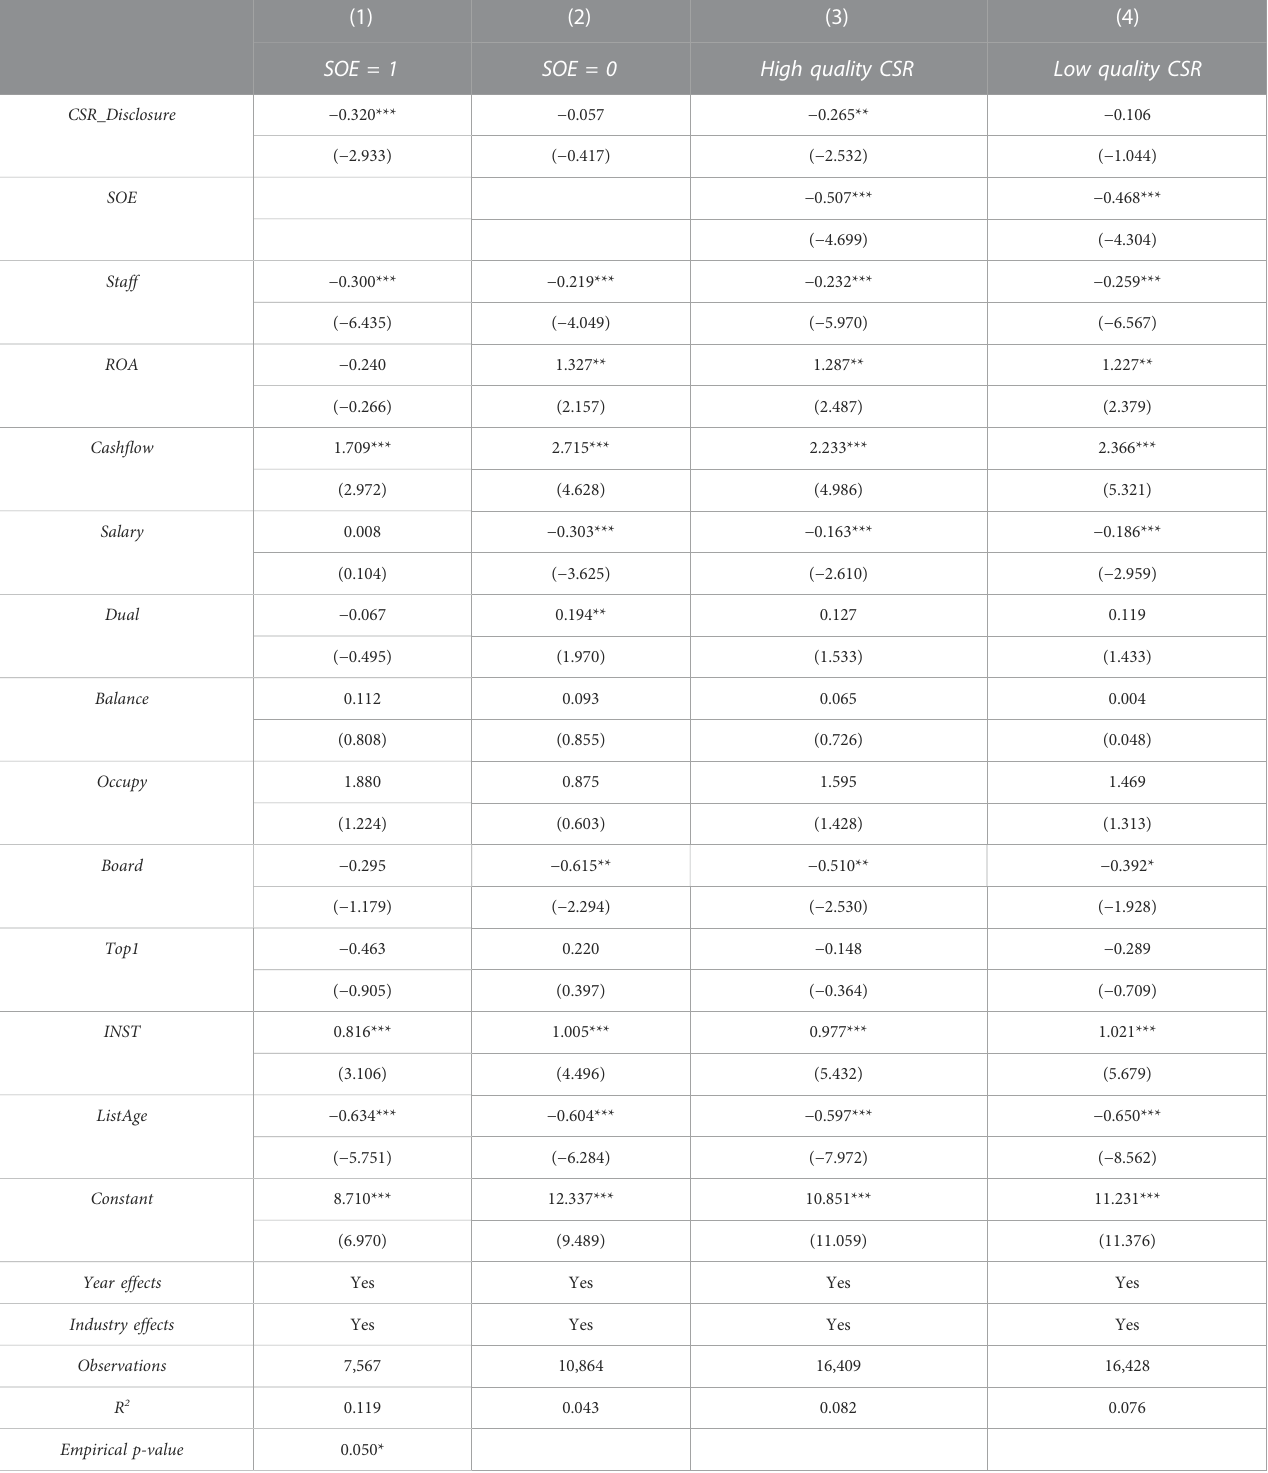
TABLE 11 The result of sub-sample test (state-owned enterprises and CSR